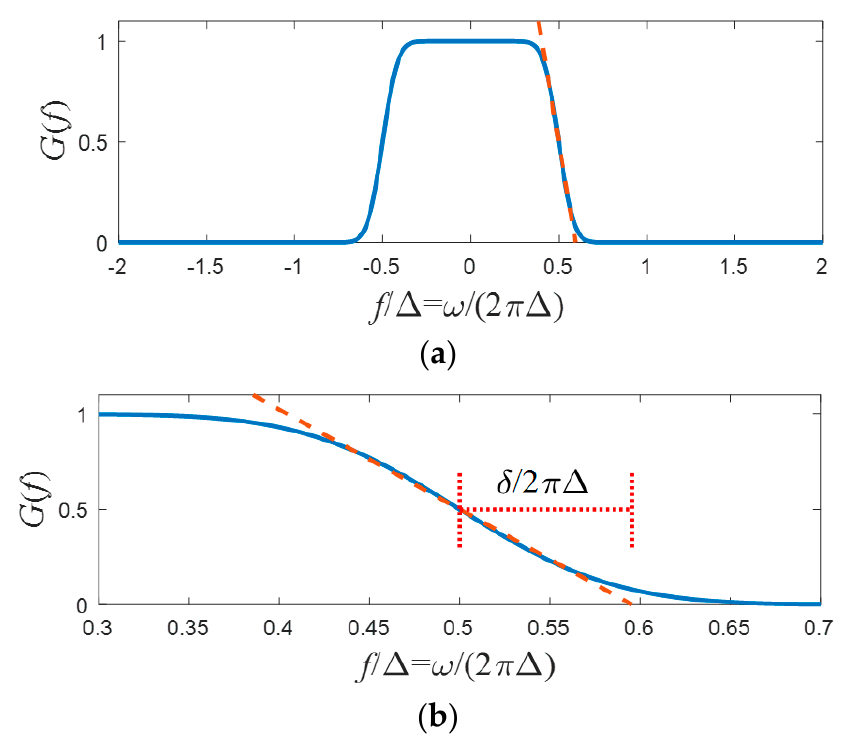
Figure 2. ( a ) The spectrum of the signal after smooth rectangular filtering and ( b ) the enlarged portion. In this case, g ( τ ,0) in Equations (3) and (5) should be replaced with the (inverse) Fourier transform of Equation (11), as